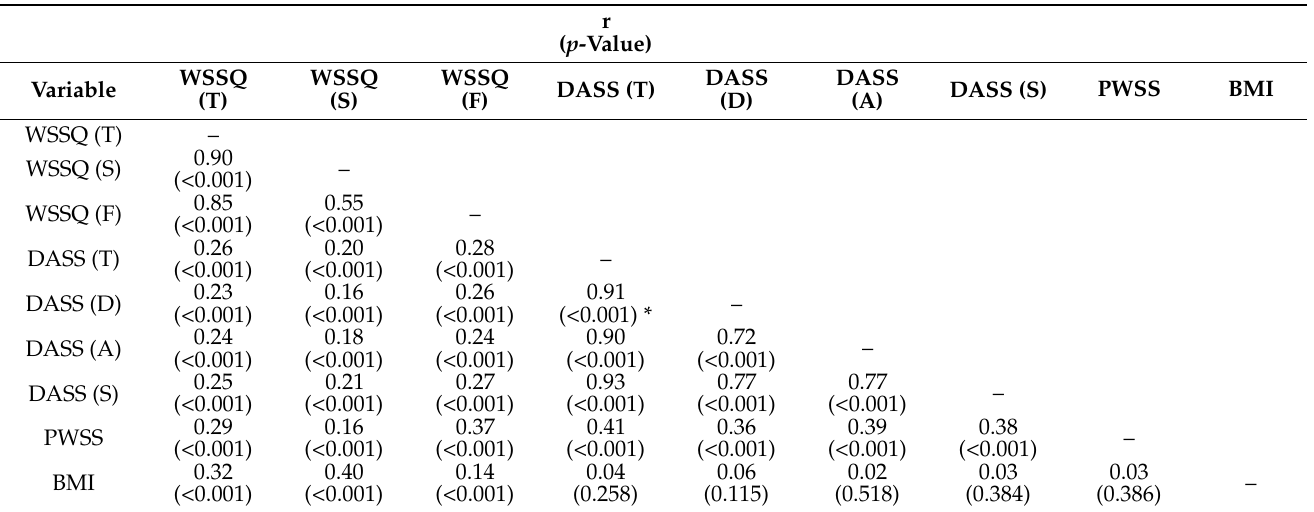
Table 4. Correlation among WSSQ, PWSS, DASS-21, and BMI. r ( p